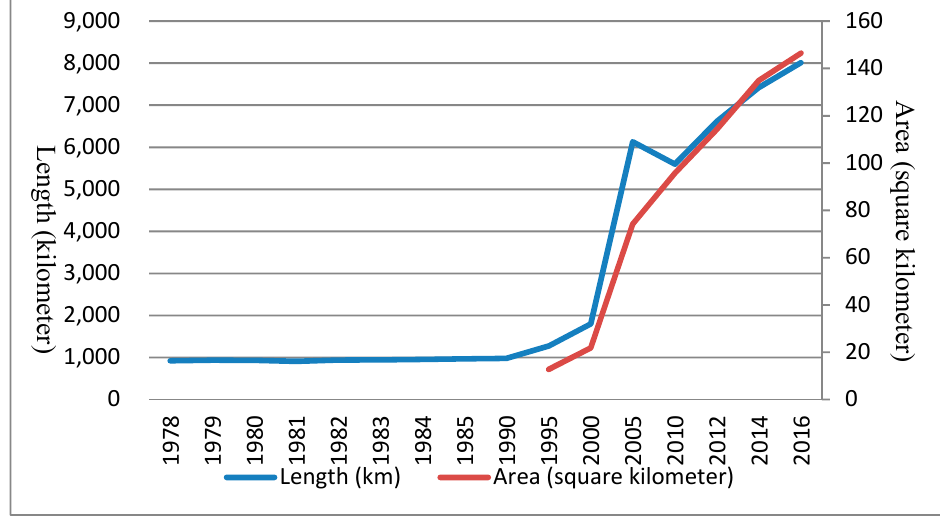
Figure 3. The length and area of road network in Nanjing.